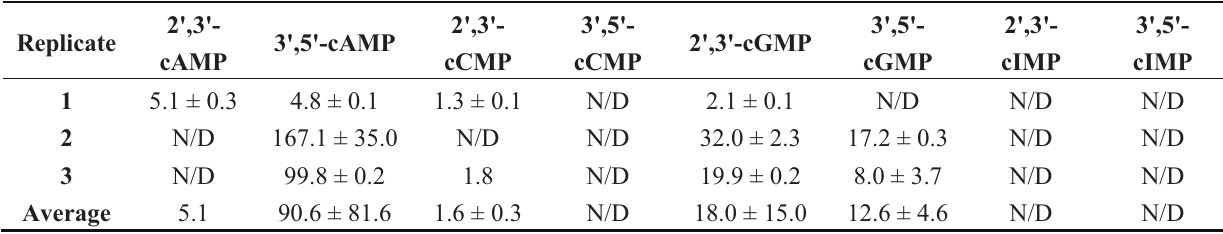
Table 3. Measured concentrations of eight cNMPs in NIH-3T3 cell line reported as mean ± SD (pmol/10 6 cells). Each cNMP concentration was calculated from three separated samples (1, 2 and 3), and each sample was analyzed in two separate